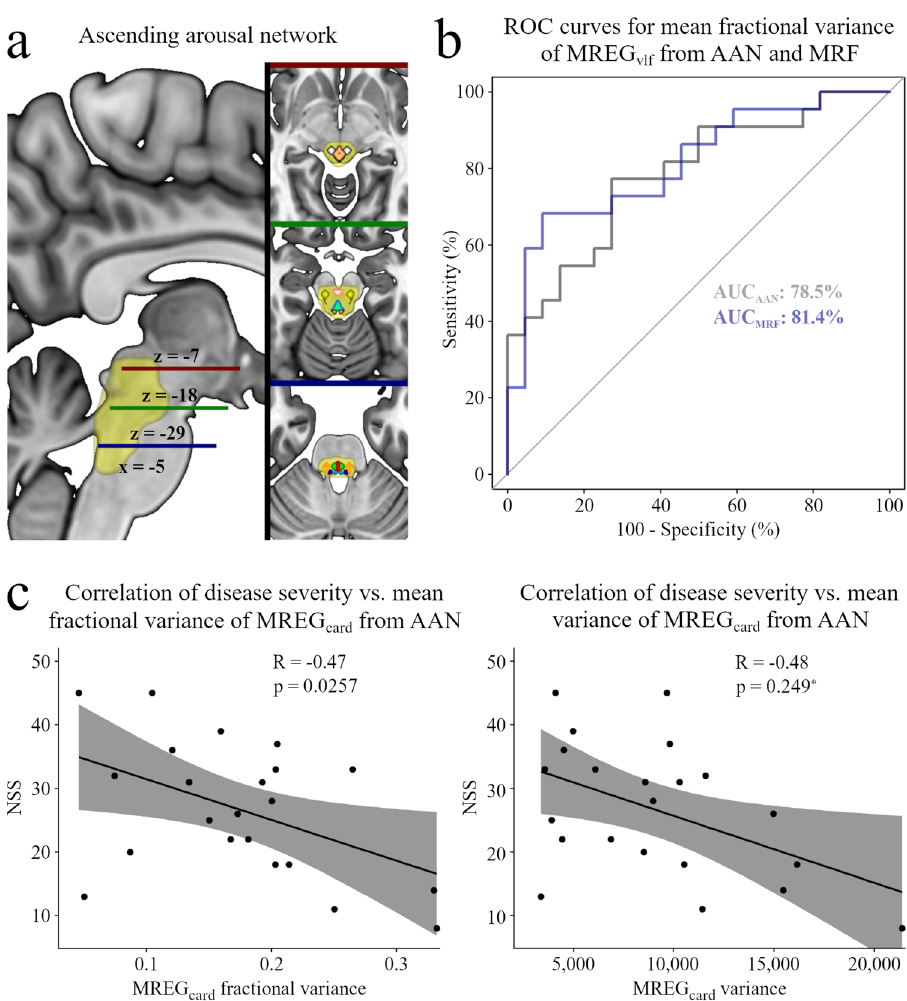
Fig. 4 ROC and correlation analysis results. a Ascending arousal network (AAN, light yellow). z = − 7 (red line): periaqueductal gray (PAG, copper), midbrain reticular formation (MRF, white). z = − 18 (green line): ventral tegmental area (VTA, light red), pedunculopontine nucleus (PPN, yellow), dorsal raphé (DR, light blue). z = − 29 (blue line): pontis oralis (PO, green), parabrachial complex (PBC, orange), median raphe (MR, red), locus coeruleus (LC, dark blue), x = displayed sagittal plane, z = displayed axial plane. b Receiver operating characteristic area under the curve (ROC AUC) for mean fractional variance at a very low frequency of the magnetic resonance encephalography (MREG vlf ) in the AAN (gray) and MRF (blue) regions shows promise as a bi- classi fi er. c Correlation between disease severity (NSS narcolepsy severity scale) and cardiac frequency fi ltered MREG data (MREG card ) variance results indicate the clinical relevance of the method. Black dots denote individual data points and gray area indicates a 95% con fi dence interval. R Pearson correlation coef fi cient, * = signi fi cant p value < 0.025, n = 22 vs.